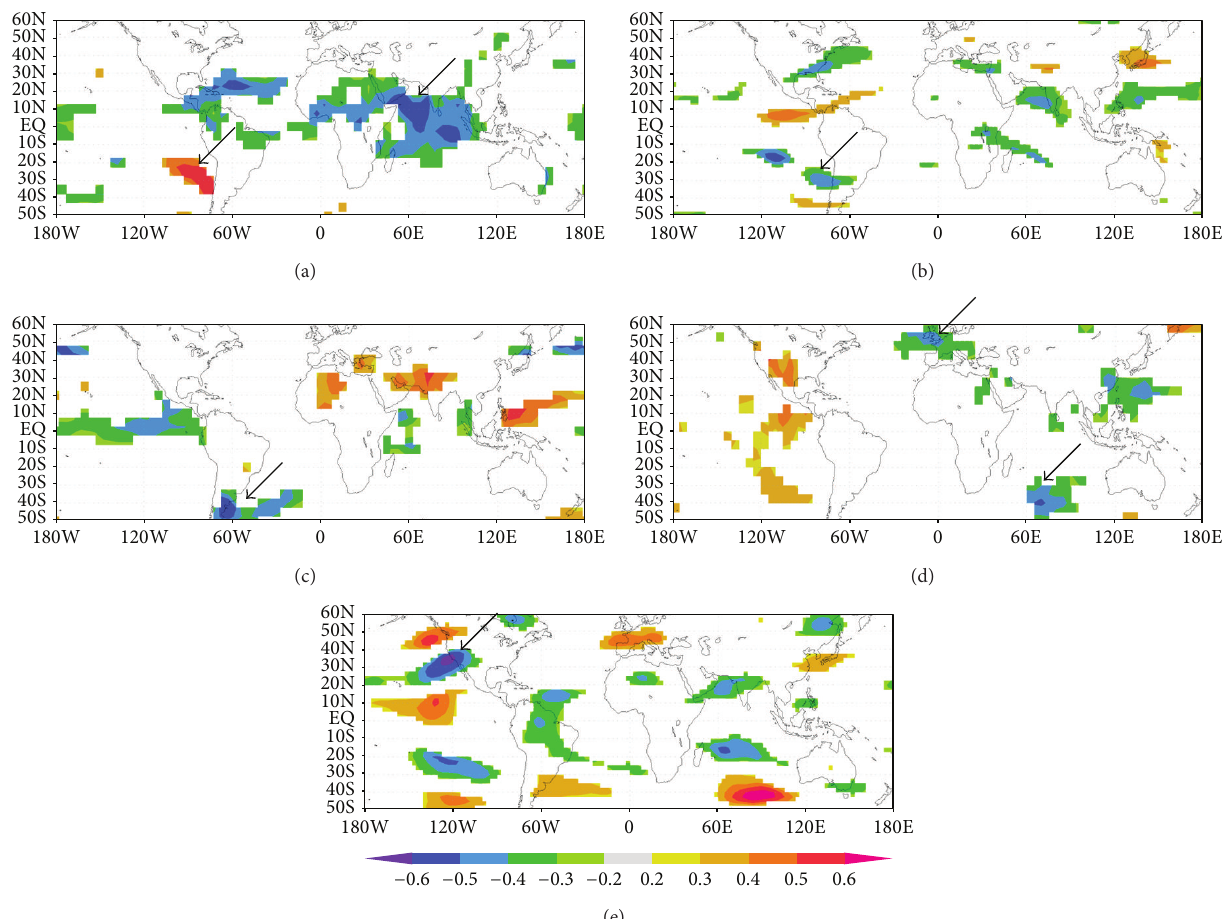
Figure 6: Correlation of MJJ southern vegetation with DJF (a) Ts and (b) 200 U fields. Correlation of ASO southern vegetation with MAM (c) Ts, (d) SLP, and (e) 200 U fields